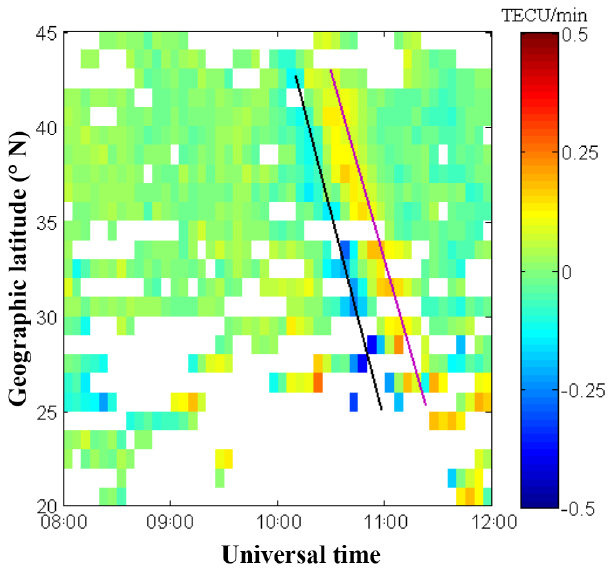
Figure 4. Snapshots of DROVT maps at the longitude of 115 ◦ E from 08:00 to 12:00UT on 17 March